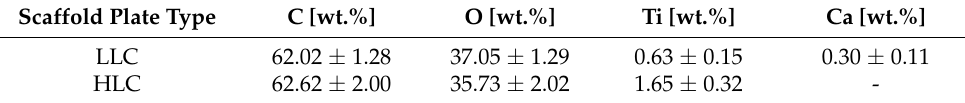
Table 2. EDS elemental composition values [Wt.%] of LLC and HLC scaffolds. Scaffold Plate